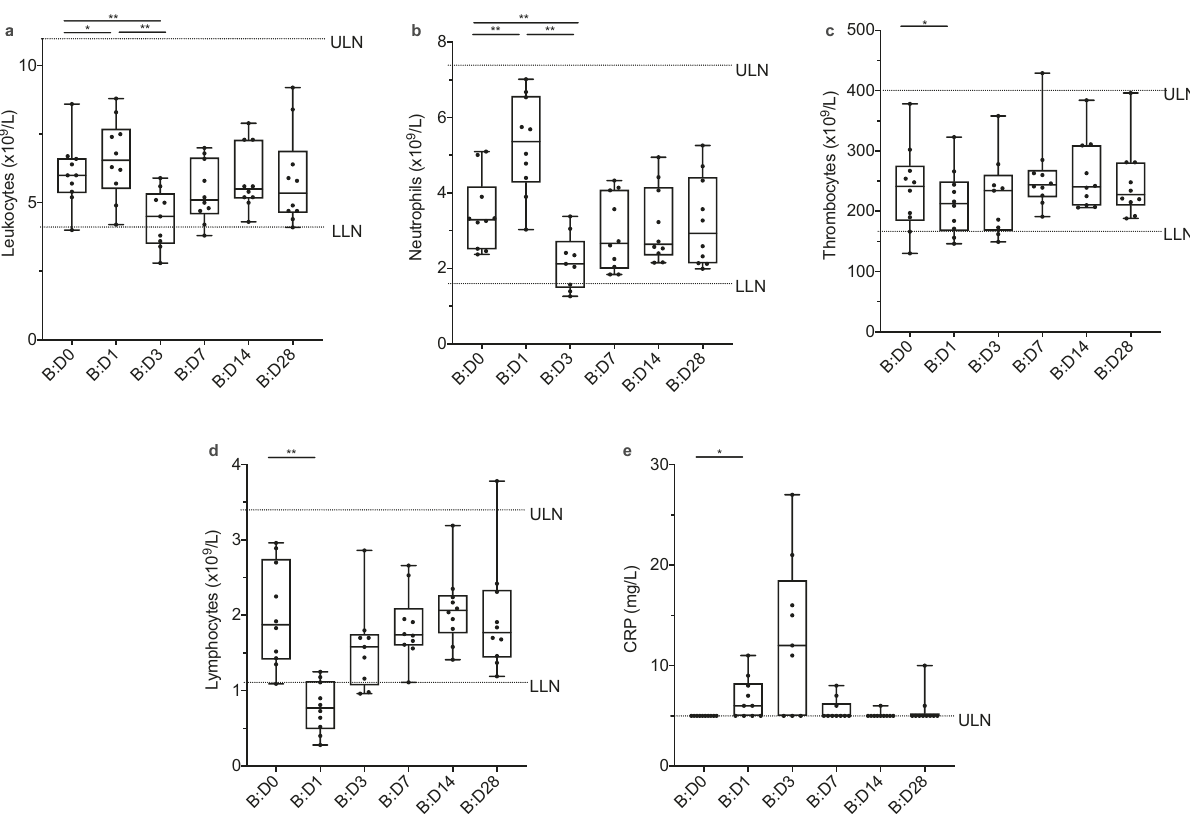
Fig. 2 Biologic monitoring. Graphs represent changes in a leukocyte, b neutrophil, c thrombocyte, and d lymphocyte counts, as well as e C-reactive protein (CRP) levels, in all booster study participants ( n = 10) after booster vaccination. We observed an increase in a leukocyte ( p = 0.014) and, by extension, b neutrophil counts ( p = 0.002) as well as e CRP levels ( p = 0.031) and a decrease in c thrombocyte ( p = 0.049) and d lymphocyte ( p = 0.002) counts on boost (B) Day 1 (B:D1) compared to B:D0. By B:D3, leukocyte and neutrophil counts had decreased ( p = 0.004 for both neutrophil and leukocyte count on B:D1 vs B:D3 and B:D0 vs. BD3). These changes from baseline were transient and not clinically signi fi cant, but indicate biologic activity after vaccination. CRP levels of <5 mg/L (below the limit of detection) were set to 5 mg/L for visualization. Boxes indicate 25 – 75 percentile; whiskers are min. to max.; medians are shown as horizonal lines within the boxes. ULN = upper limit of normal. LLN = lower limit of normal. * p < 0.05, ** p < 0.005, differences assessed using a two-sided Wilcoxon matched-pairs signed rank test. Source data are provided as a Source Data fi 12-fold in the VNT (reciprocal titer 5.10 [95% CI 1.74 – 14.9] on D42 vs. 60.7 [95% CI 39.0 – 94.3] on B:D28). Remarkably, all 5 participants who had not developed nAb levels above the threshold for positivity after the initial two vaccinations as measured by VNT had now developed positive nAb levels by B:D14 (Fig. 4c). Neutralizing antibodies against MERS-CoV were not detected in the serum of controls ( n = 4; Fig. 4a, b).